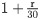
Dot plots representing the participants’ performance for the task outcomes including muscular strength (1RM), motivation, muscular endurance (SEI), perceived exertion (RPE), and HR.Panel a shows a significant difference between the 1RM of the athletes in true vs. sham tDCS sessions (p <0.05). The 1RM was calculated through 1RM = w (1+r30), considering r >1 (48), where r is the number of repetitions performed and w is the amount of weight. Panel b indicates no significant difference for the motivation of bodybuilders in sham vs. real sessions evaluated through VAS, a continuous single-item fatigue scale ranging from 0 (no fatigue) to 10 (severe fatigue) (p<0.05). Panel c indicates a significant difference in SEI [multiplication of the amount of weight (30% of their 1RM) by the number of successive exercise] for the sham vs. real tDCS session (p<0.05). Panel d shows a significant difference between the RPE in sessions 1 and 2 (p<0.05). Panel e shows a significant difference between HR in the last 12 lifts (the average HR of each two leg extension exercises is plotted in the graph) in sham and real tDCS sessions (p<0.05). Paired t-test was used with the p value significance level set at 0.05. ns: non-significant.